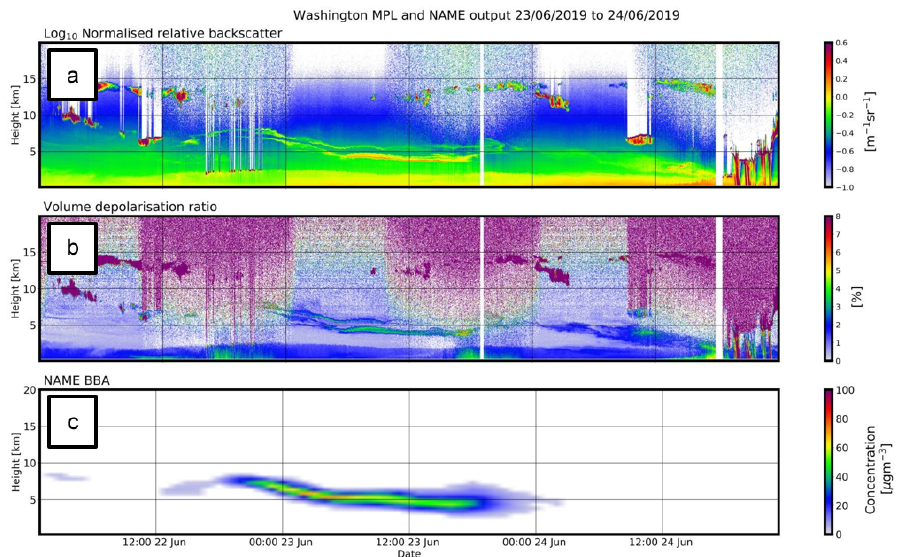
Figure 8. Washington MPL lidar data: (a) normalised relative backscatter [m − 1 sr − 1 ]; (b) volume depolarisation ratio [%]; (c) NAME air concentrations for BBA cloud [µgm − 3 ]. The NAME data have been scaled to match the lidar concentrations estimates. Data for 22 to 24 June 2019.